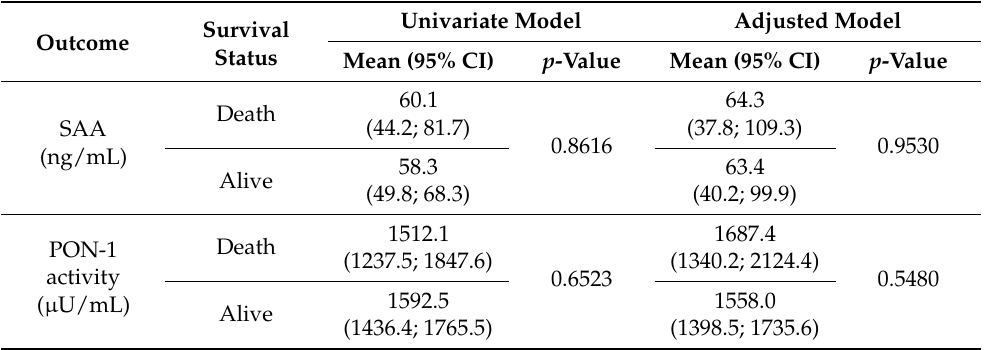
Table 4. Association between survival status and SAA or PON-1 activity in patients with SARS- CoV2